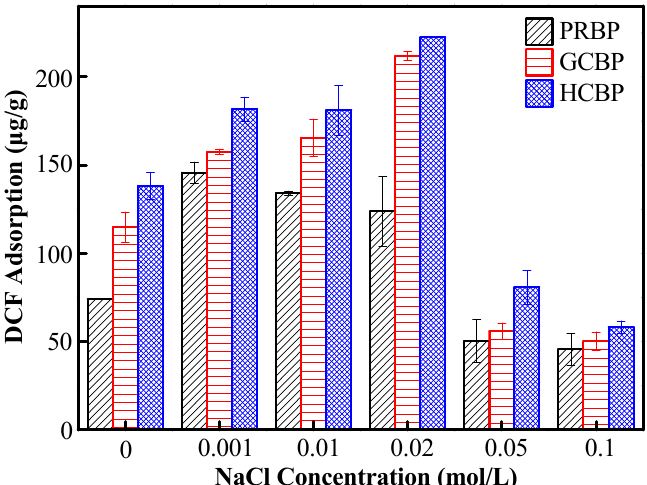
Figure 8. Effect of ionic strength on the adsorption of DCF onto PRBP, GCBP, and HCBP.